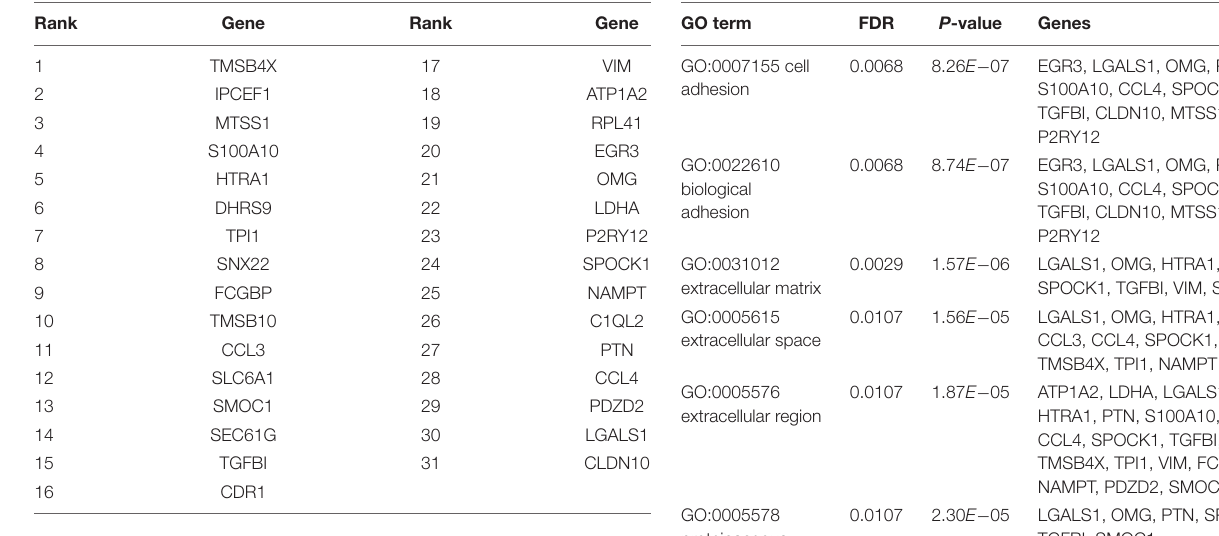
TABLE 2 | The confusion matrix of the 31 selected genes.